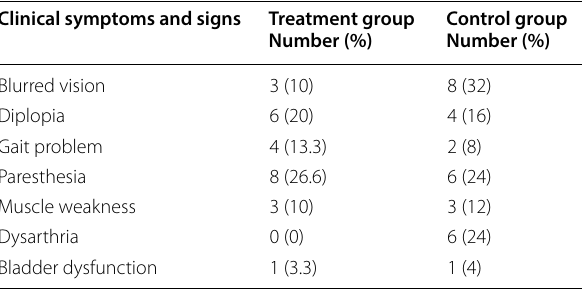
Table 2 The clinical manifestations of disease in each study group